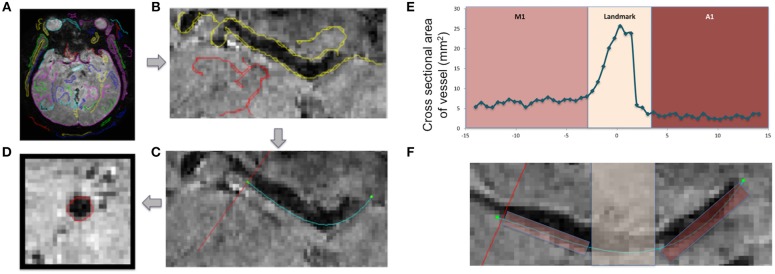
Technique for vessel caliber calculation and visualization. Axial slice depicting the vasculature of interest is identified on a high resolution T2*-weighted image (A). The edge of each vessel is identified (B) and fit to a polynomial (teal line in C). Slices are reconstructed perpendicular to the teal line (red line in C) along the length of the vessel, and the cross-sections are visualized and calculated on these reconstructed slices (D). Plots of cross-sectional area (E) along the length of a vessel (F) are presented in a control subject, showing M1 and A1 segments. The region of increased area at the location where the internal carotid artery merges with Circle of Willis was used as a landmark for aligning patient data (Landmark).